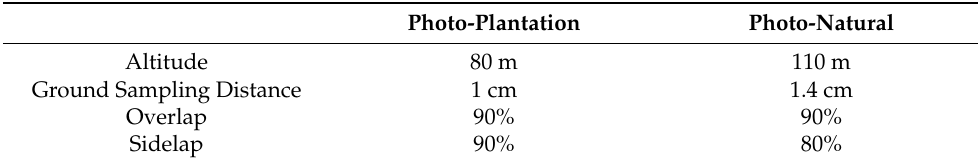
Table 2. The flight parameters of the UAV Photogrammetry